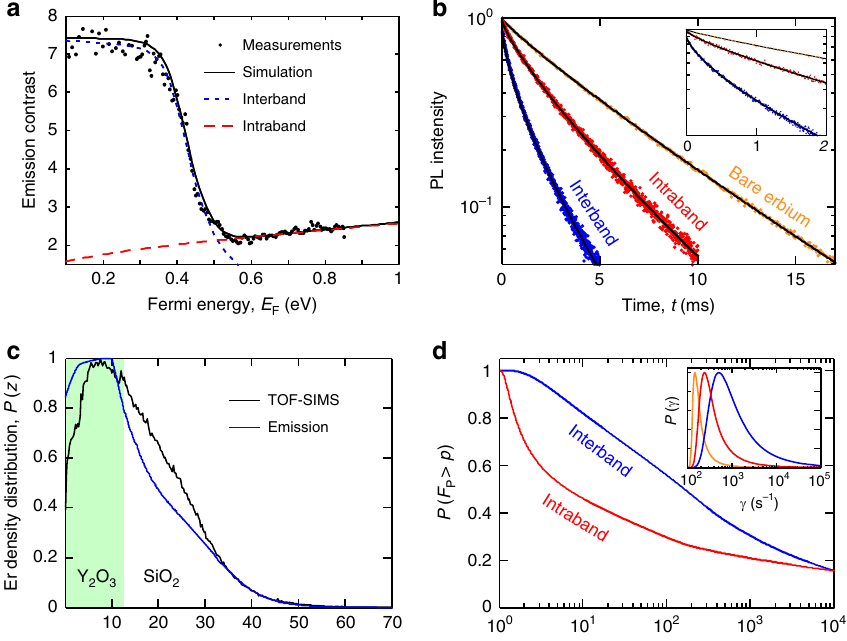
Fig. 2 Ef fi cient energy fl ow from erbium emitters to graphene. a Measured emission contrast, de fi ned as the emission with the excitation laser shining outside graphene divided by the emission with the laser on graphene, as a function of the Fermi energy (black dots). The black solid line represents the calculated emission contrast from N erbium ions located at different distances z i from graphene (see “ Methods ” ), using the total graphene conductivity. The red (blue) dotted line represents the calculated emission contrast by only considering the conductivity of the intraband (interband) excitation, showing the different microscopic origins of the emitter – graphene interactions at high and low E F . The interband contribution (blue) quickly drops when E F > 0.4 eV, due to Pauli blocking, whereas the intraband contribution (red) steadily rises with E F . b Measured decay curves of erbium ions for three cases: graphene in the interband regime ( E F = 0.3 eV, blue dots), graphene in the intraband regime ( E F = 0.8 eV, red dots), and without graphene (orange dots). The black solid lines are the best- fi t stretched-exponential functions. The inset focuses on the beginning of the decay curves, illustrating the multi-exponential behavior. c Erbium density distribution (normalized to maximum) vs. erbium – graphene distance obtained from the combined analysis of the emission contrast and the decay curve of the interband regime (blue) and from TOF-SIMS measurements (black). d Cumulative distribution of the decay enhancement factor calculated for the interband (blue) and the intraband (red) regimes. These curves show that about 80% (50%) of the ions have F P > 10 for the interband (intraband) regime, and approximately 25% of ions have F P > 1000 for both regimes. The inset shows the total decay rate distributions directly obtained from the multi-exponential fi tting of the experimental decay curves (see “ Methods ” ). The colors are the same as in b